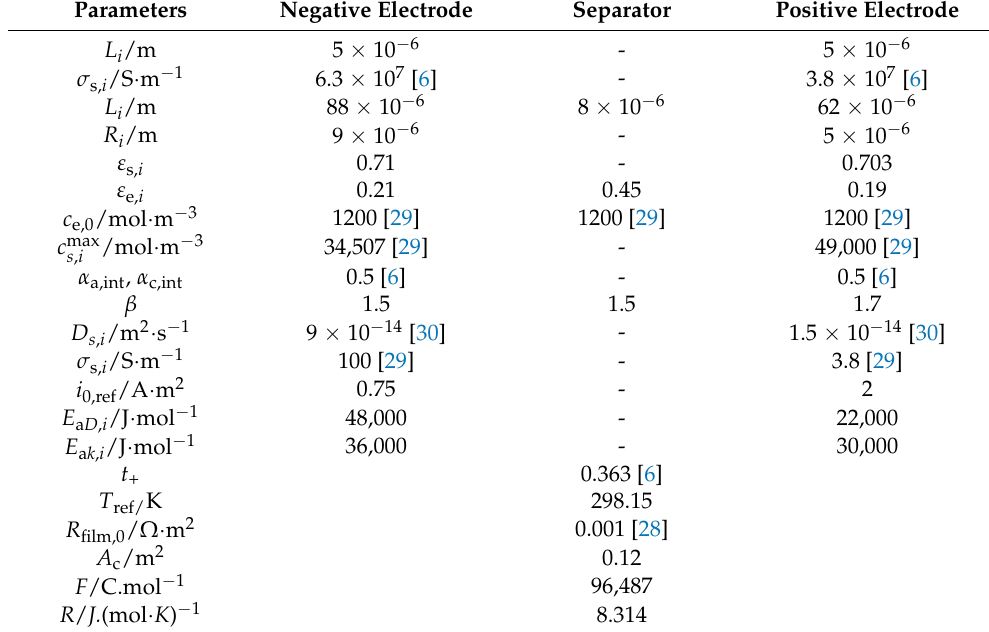
Table 1. Parameters used in the electrochemical model.